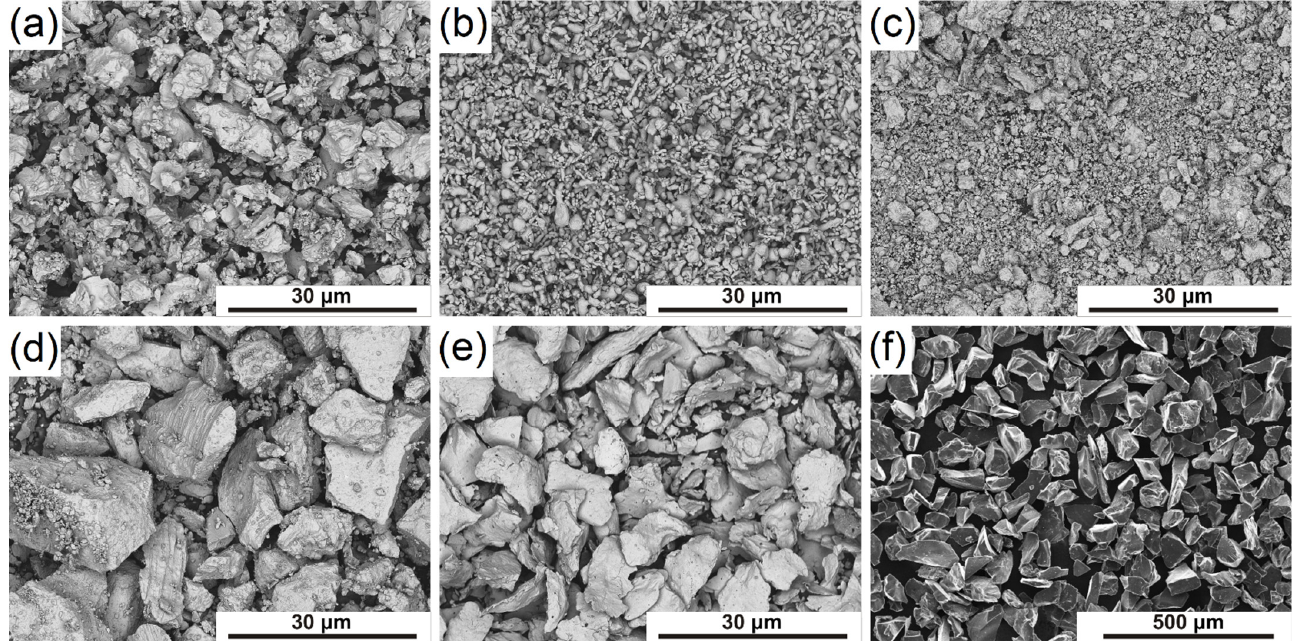
Figure 1. SEM micrographs of elemental powders used to prepare the mixture: ( a ) titanium, ( b ) Figure 1. SEMmicrographsofelementalpowdersusedtopreparethemixture: ( a )titanium, ( b ) aluminum, aluminum, ( c ) molybdenum, ( d ) vanadium, ( e ) chromium, and ( f ) boron carbide. ( c ) molybdenum, ( d ) vanadium, ( e ) chromium, and ( f ) boron